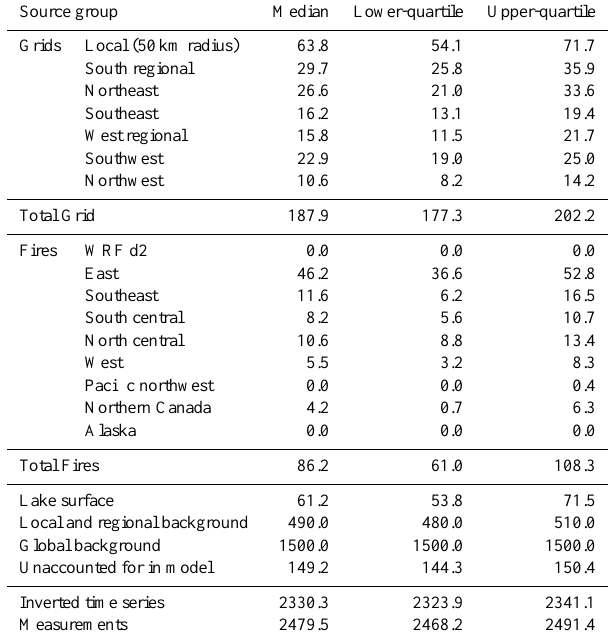
Fig. 11. Map of impacts at the receptor site. Color indicates the average GEM concentration at the measurement site due to emissions in that cell. Domain names and boundaries used in Tables 3 and 5 shown in pink. Areas with zero emissions shown in white.